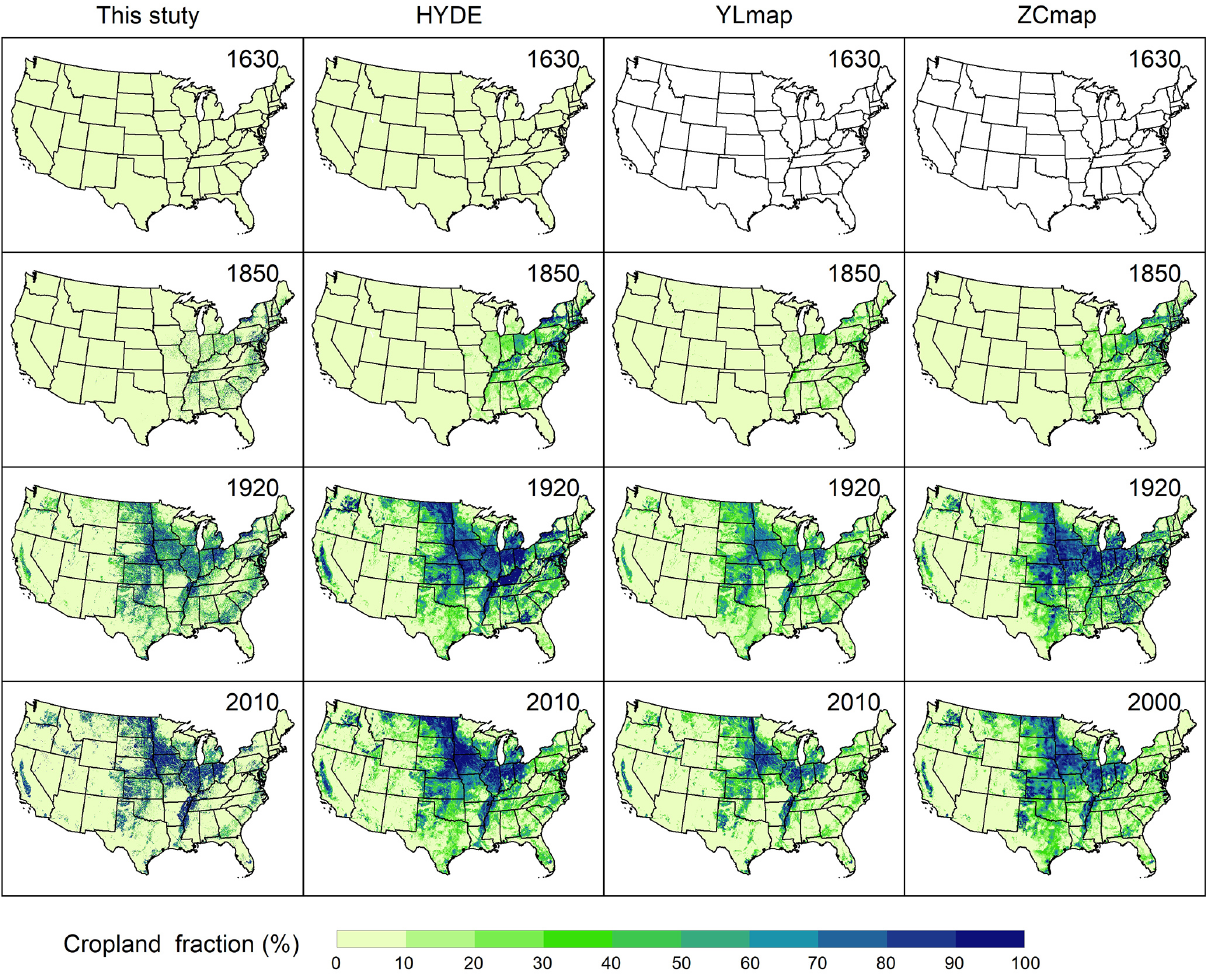
Figure 14. Comparison of cropland maps among four datasets for the conterminous United States: this study (first column), the History Database of Global Environment (HYDE), Yu and Lu (2017) cropland density (YLmap), and Zumkehr and Campbell (2013) historical fractional cropland areas